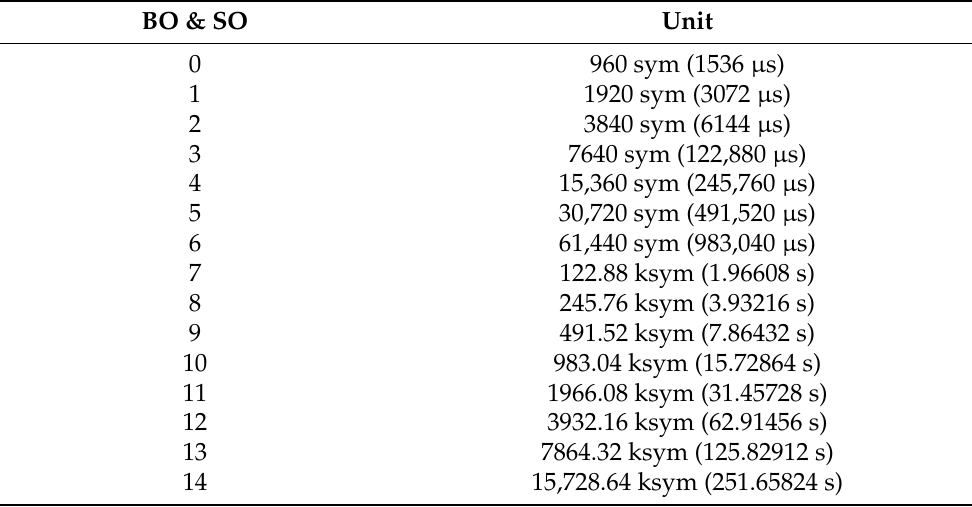
Table 2. SO and BO variables time representation (250kbps O-QPSK